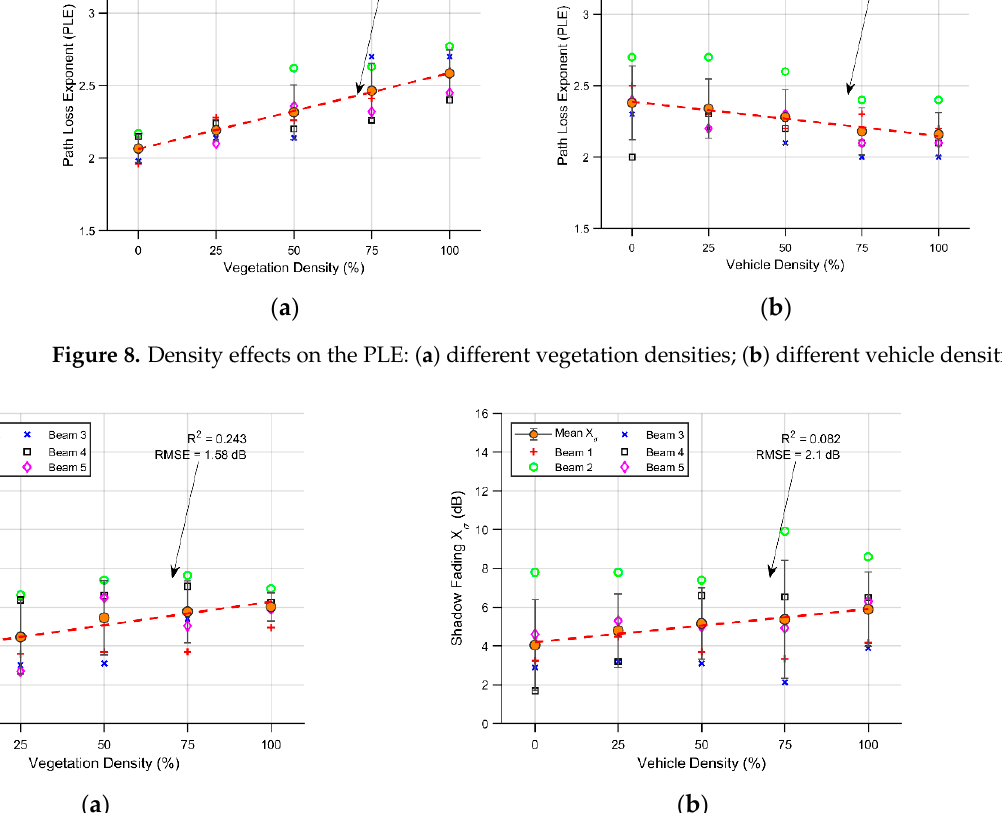
Figure 9. Effects of density on shadow fading: ( a ) different vegetation densities; ( b ) different vehicle densities.